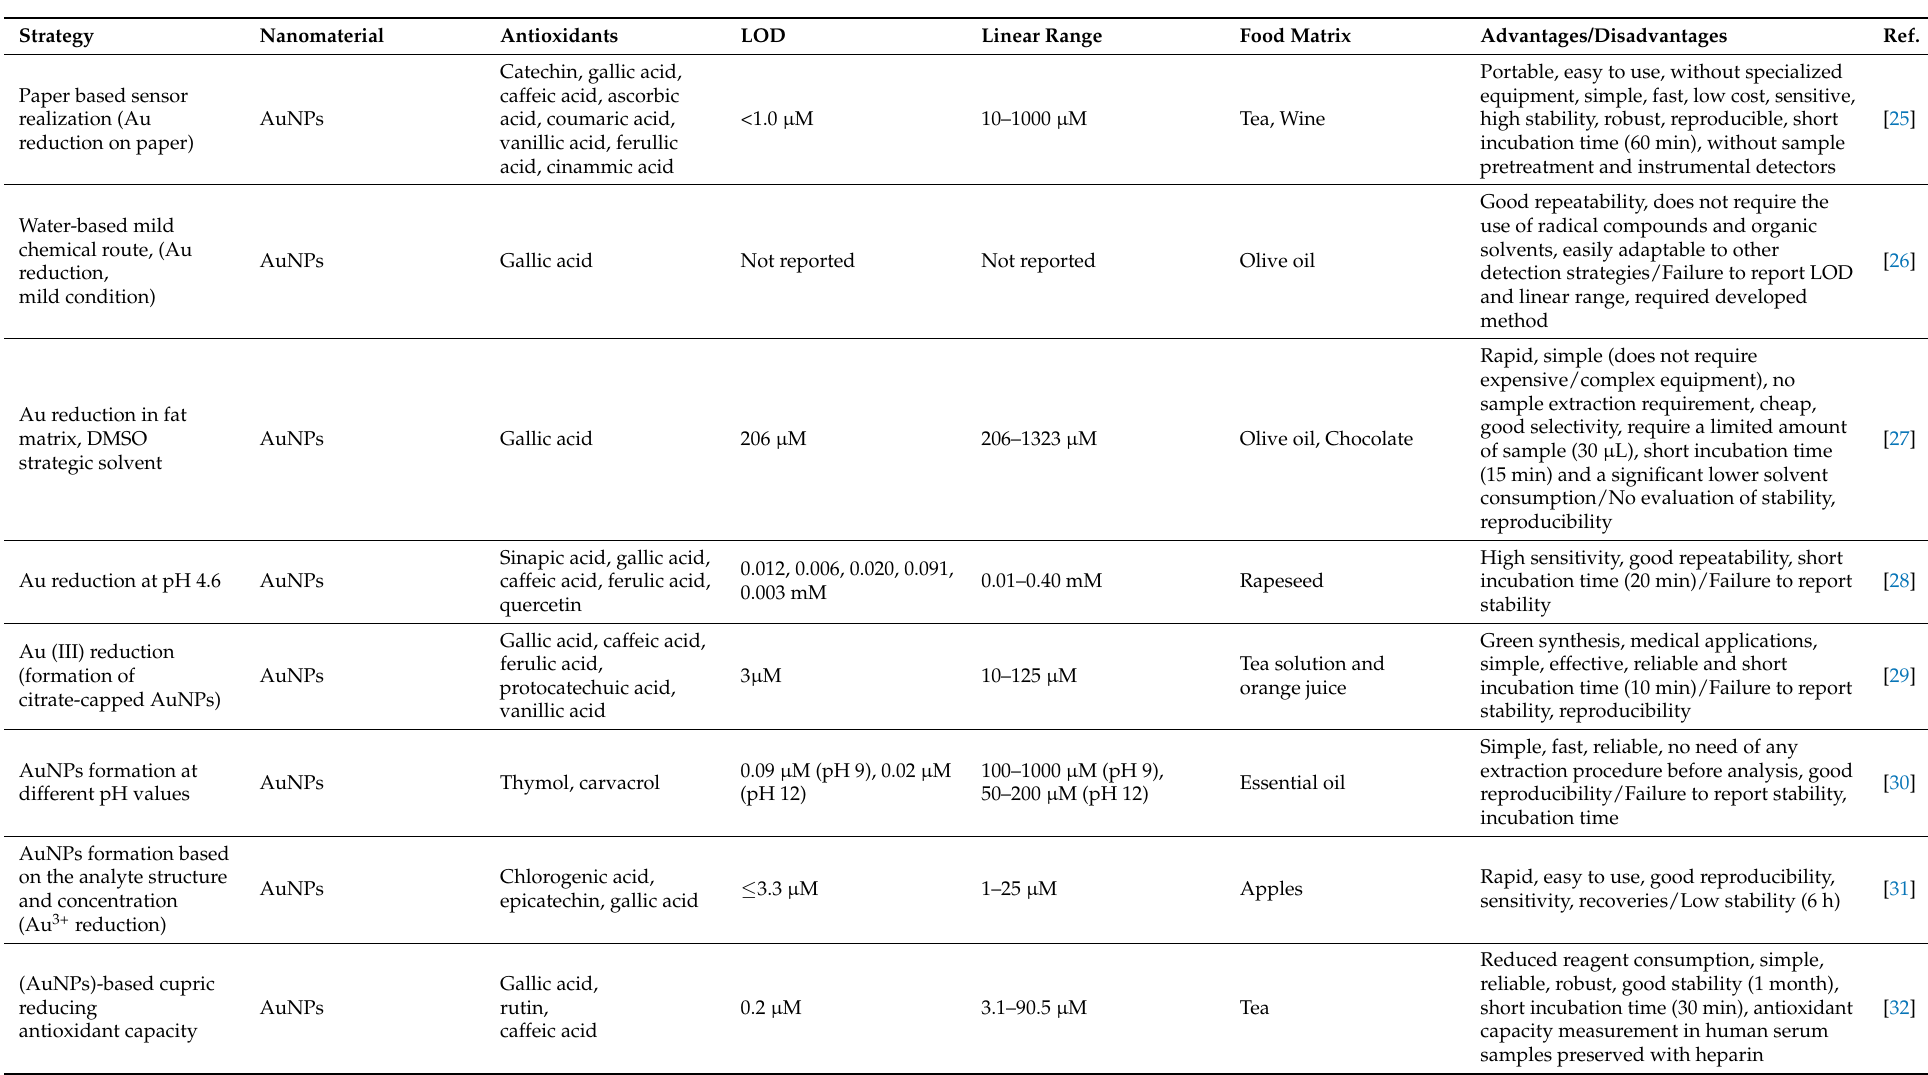
Table 1. Representative examples of recent developed colorimetric assays for the determination of antioxidants in food